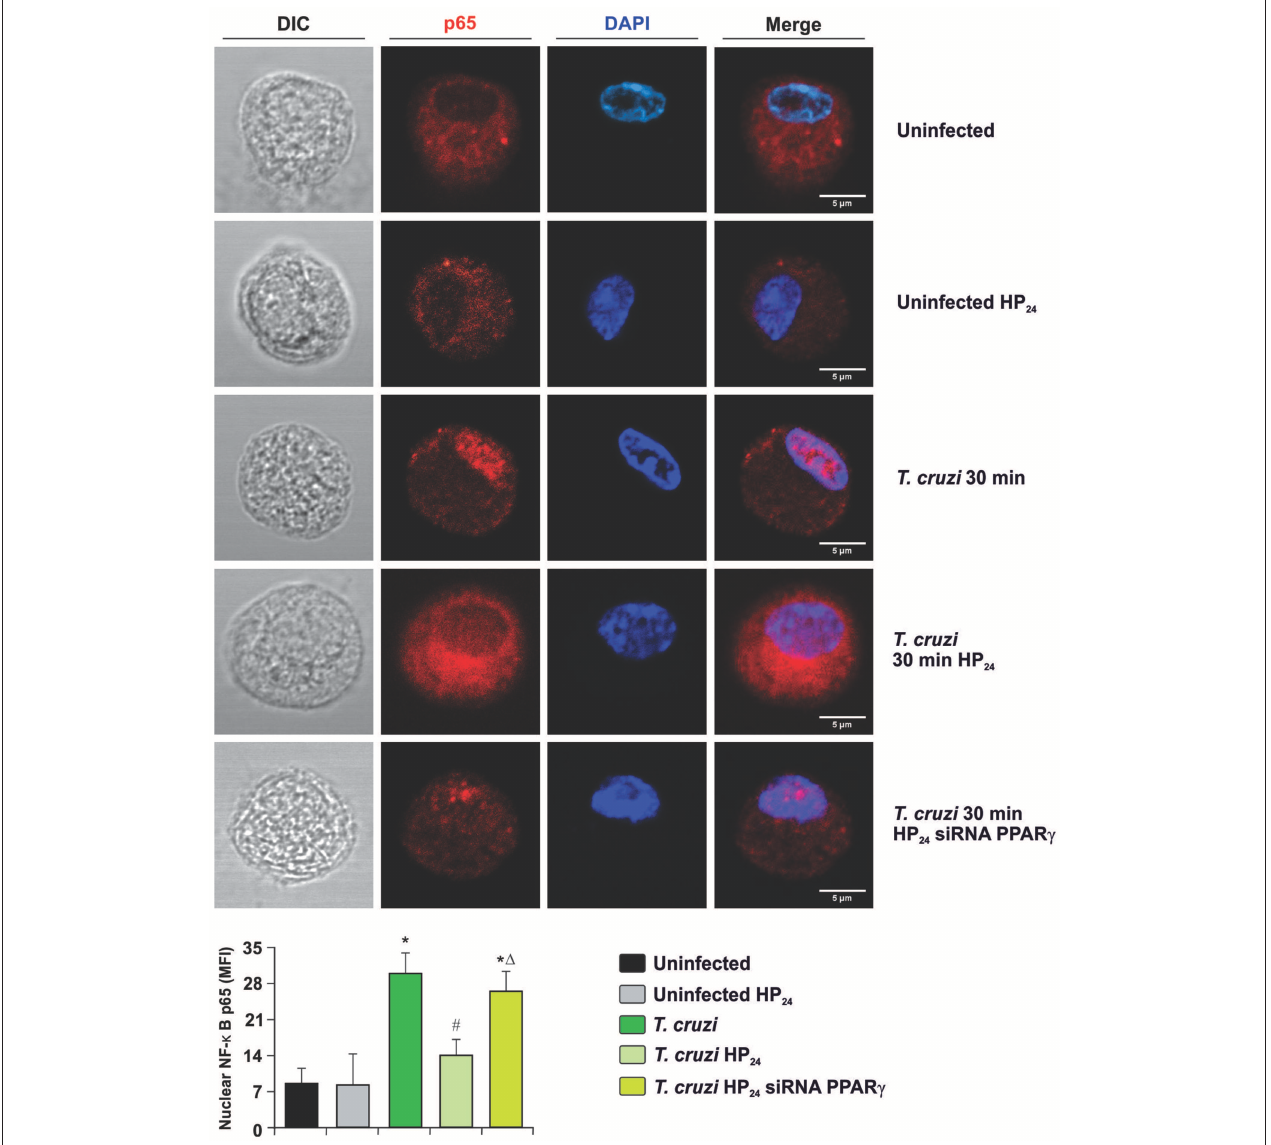
FIGURE 8 | HP 24 inhibits the NF- κ B pathway by PPAR γ -dependent mechanisms. Peritoneal macrophages were obtained and transfected with PPAR γ -siRNA for 72h. Transfected or non-transfected cells were treated with HP 24 (100 µ M) since 30min before infection. Then, these cells were infected for 30min with T. cruzi (parasite:cell ratio 5:1). p65 expression was detected by confocal microscopy with a rabbit polyclonal anti-p65 antibody and a secondary goat anti-rabbit Alexa 647-labeled antibody. Cell nuclei were stained with DAPI. Representative microphotographs are shown. MFI represents nuclear p65. Scale bar: 5 µ m. Results are expressed as the mean MFI of three independent experiments. * P < 0.05 vs. uninfected cells, # P < 0.05 vs. T. cruzi -infected cells. 1 P < 0.05 vs. T. cruzi -infected HP 24 -treated